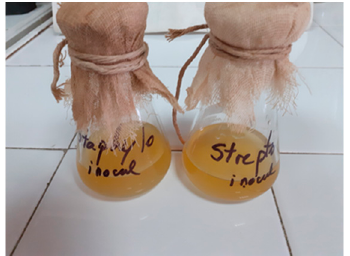
Figure 3. Erlenmeyer flasks with bacterial inoculum.